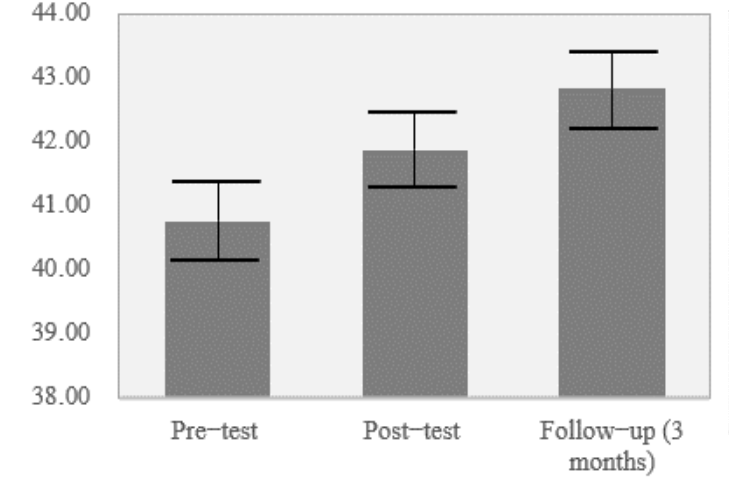
Figure 2. Mean scores in health and subjective well-being for the pre-test, post-test, and 3-month follow-up.